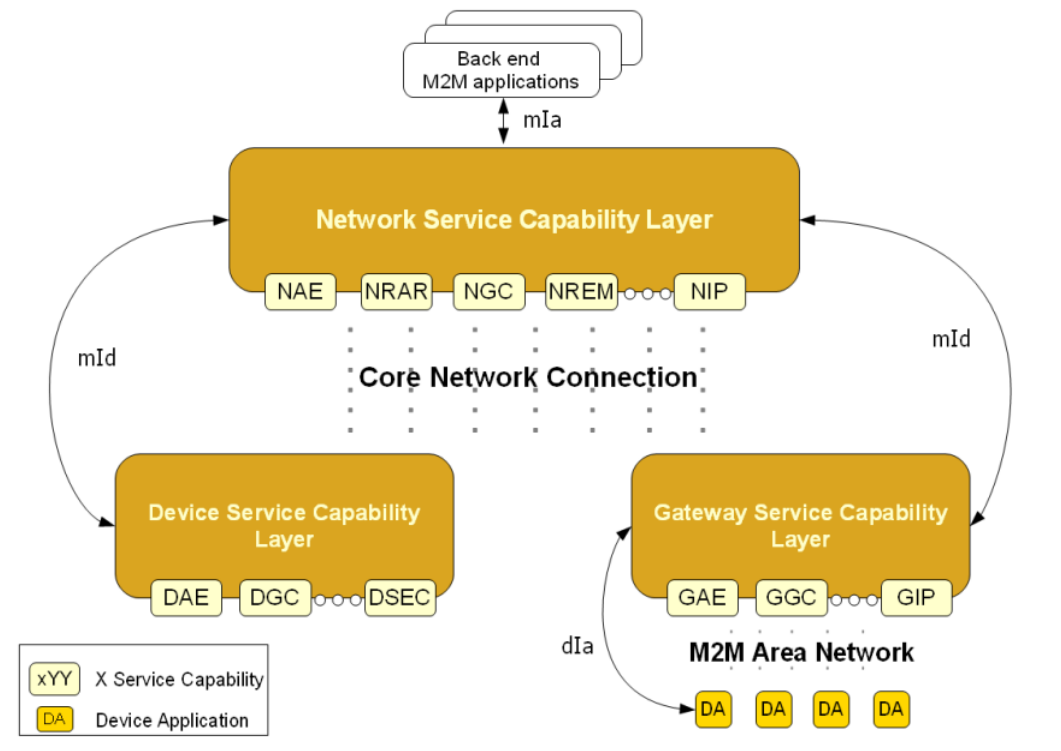
Figure 7. Architecture of ETSI M2M Service